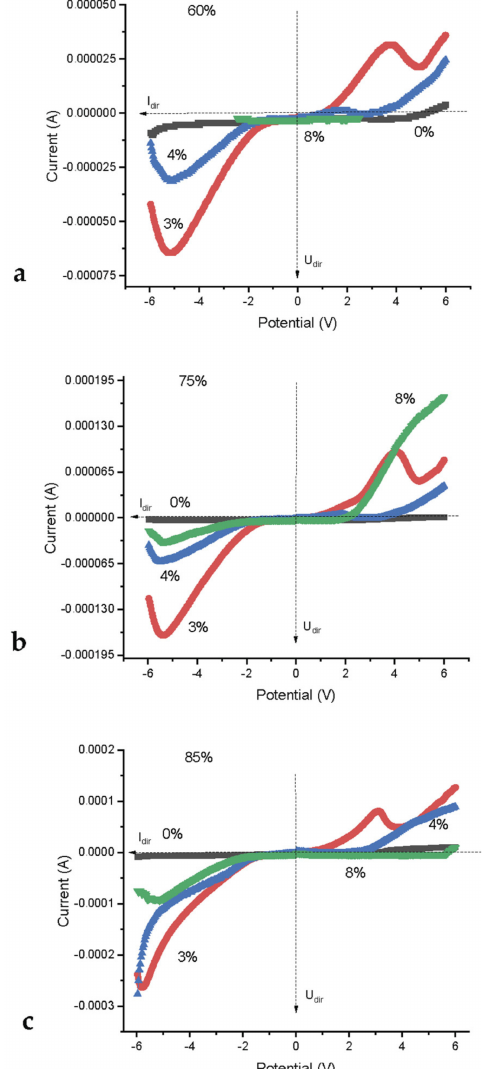
Figure 6. Dependence of current on voltage at contacts 400–600 based on ZrO 2 - x mol% Y 2 O 3